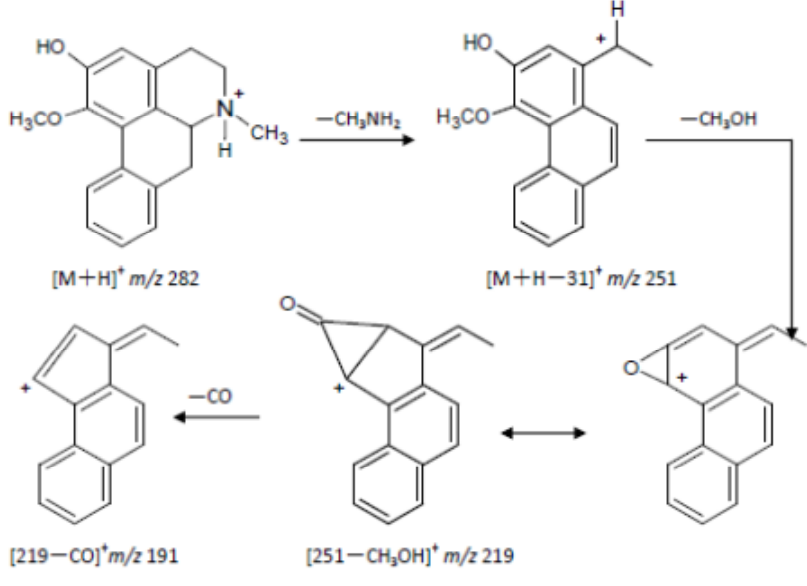
Figure 8. Fragmentation pathway of 2H1M .